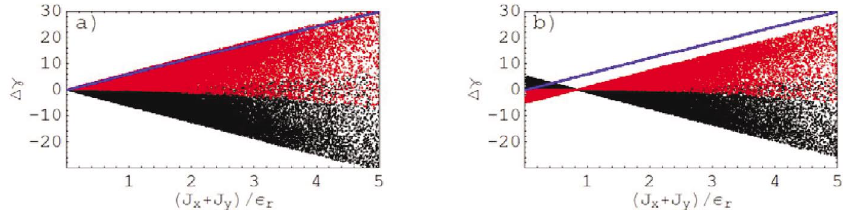
(cid:2) J (cid:8) =" : (a) zero relative phase between two laser waves, (b) relative phase shift is x y r (cid:2) J (cid:8) =" . x y r